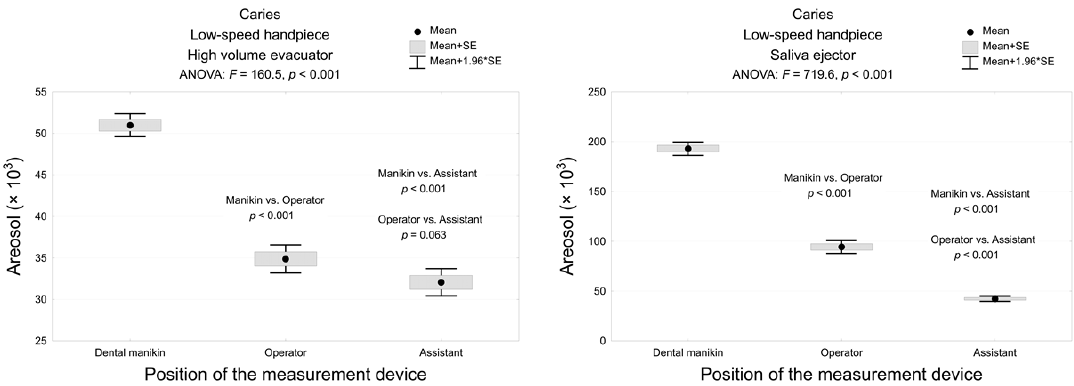
Figure 5. The amount of the dental spray during caries removal with low-speed handpiece with a high volume evacuator or saliva ejector, measured in 3 areas and the analysis of variance and post- hoc test (multiple comparisons using the Tukey test)